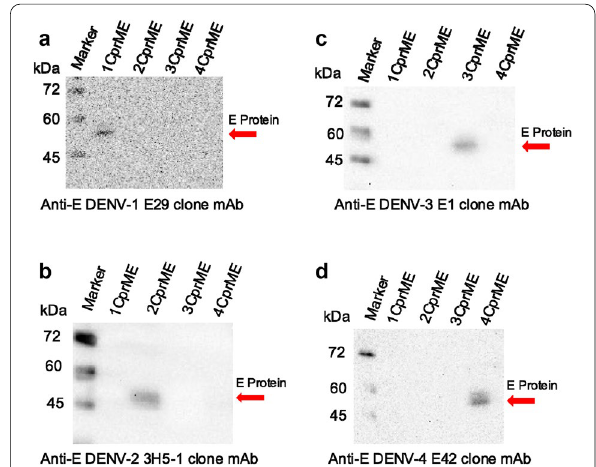
Fig. 3 Western blot of purified ( a ) 1CprME, ( b ) 1prME, ( c ) 4CprME, and ( d ) 4prME polypeptides for the cross-reaction test was performed on the DENV-1 and DENV-4 constructs with specific serotype monoclonal antibodies for each